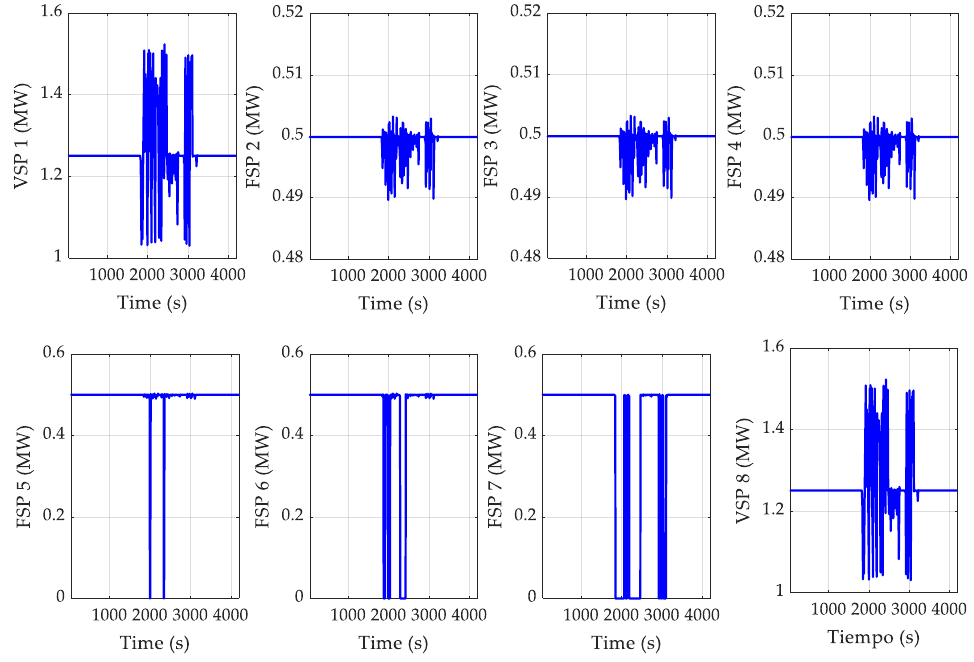
Figure 10. Power consumed by the pumps when a wind speed fluctuation is simulated.